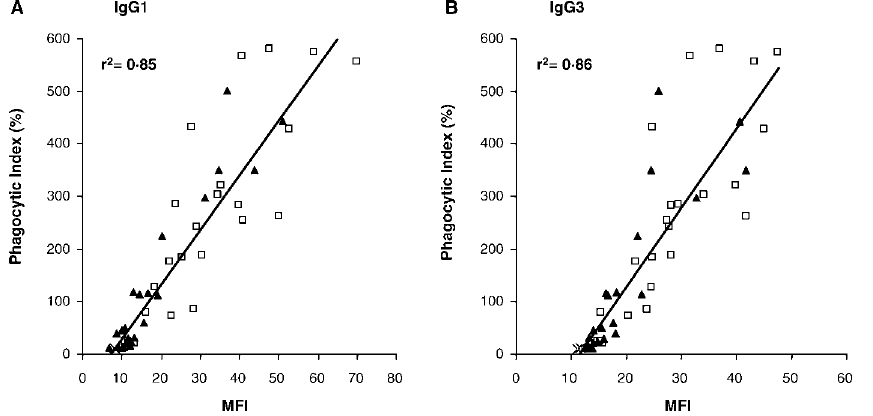
Figure 6. Correlation between Levels of VSA-PAM-Specific IgG1 and IgG3 and Plasma Opsonizing Activity Plasma levels of IgG1 and IgG3 subclasses specific for VSA expressed by CS2 PEs measured by flow cytometry were compared with their corresponding phagocytic index. ‘‘ X ’’ symbols represent plasma from nonimmune donors ( n ¼ 3), open squares represent plasma from multigravid HIV-negative women ( n ¼ 23), and solid triangles represent plasma from multigravid HIV-infected women ( n ¼ 23). Levels of IgG1 and IgG3 specific for VSA expressed by CS2 PEs correlated significantly with plasma opsonizing activity ( r 2 ¼ 0.85 and r 2 ¼ 0.86 respectively, p , 0.001). Statistical significance was assessed by the Spearman correlation coefficient, with F -test.